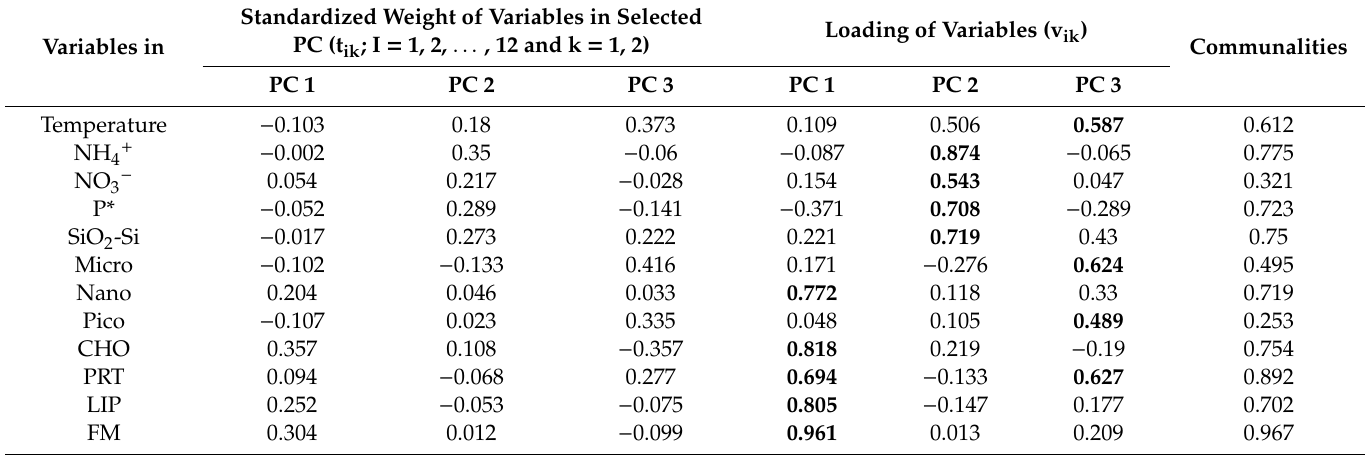
Table 3. Principal component analysis (PCA) results in Jaran Bay during the observation period.